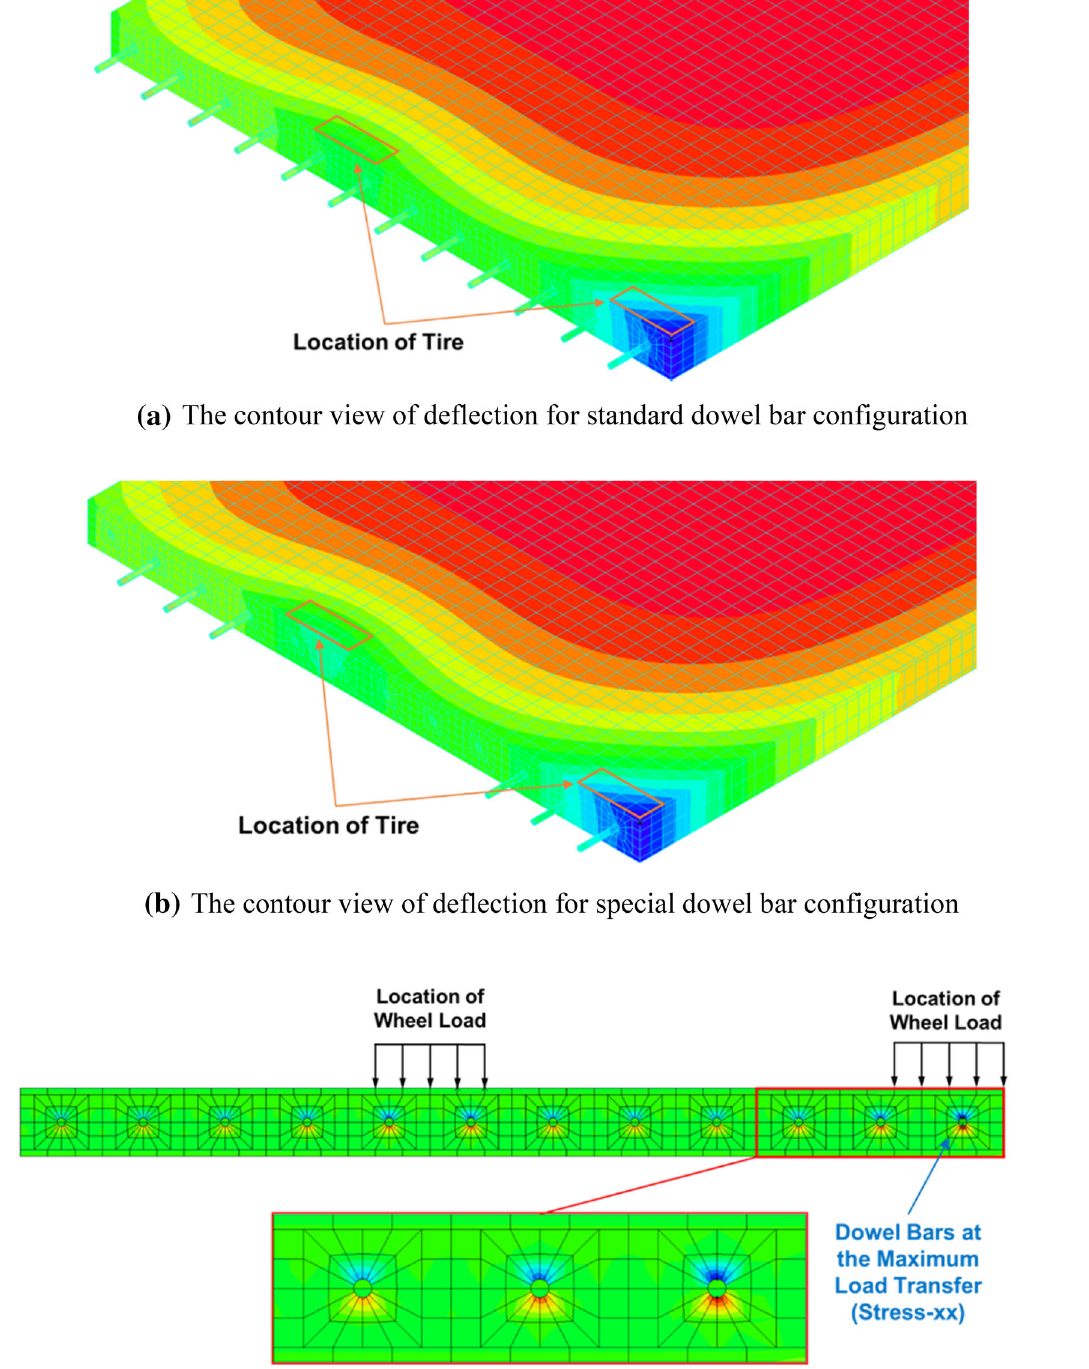
Fig. 12 The contour plots of deflections in concrete slab for two different dowel bar